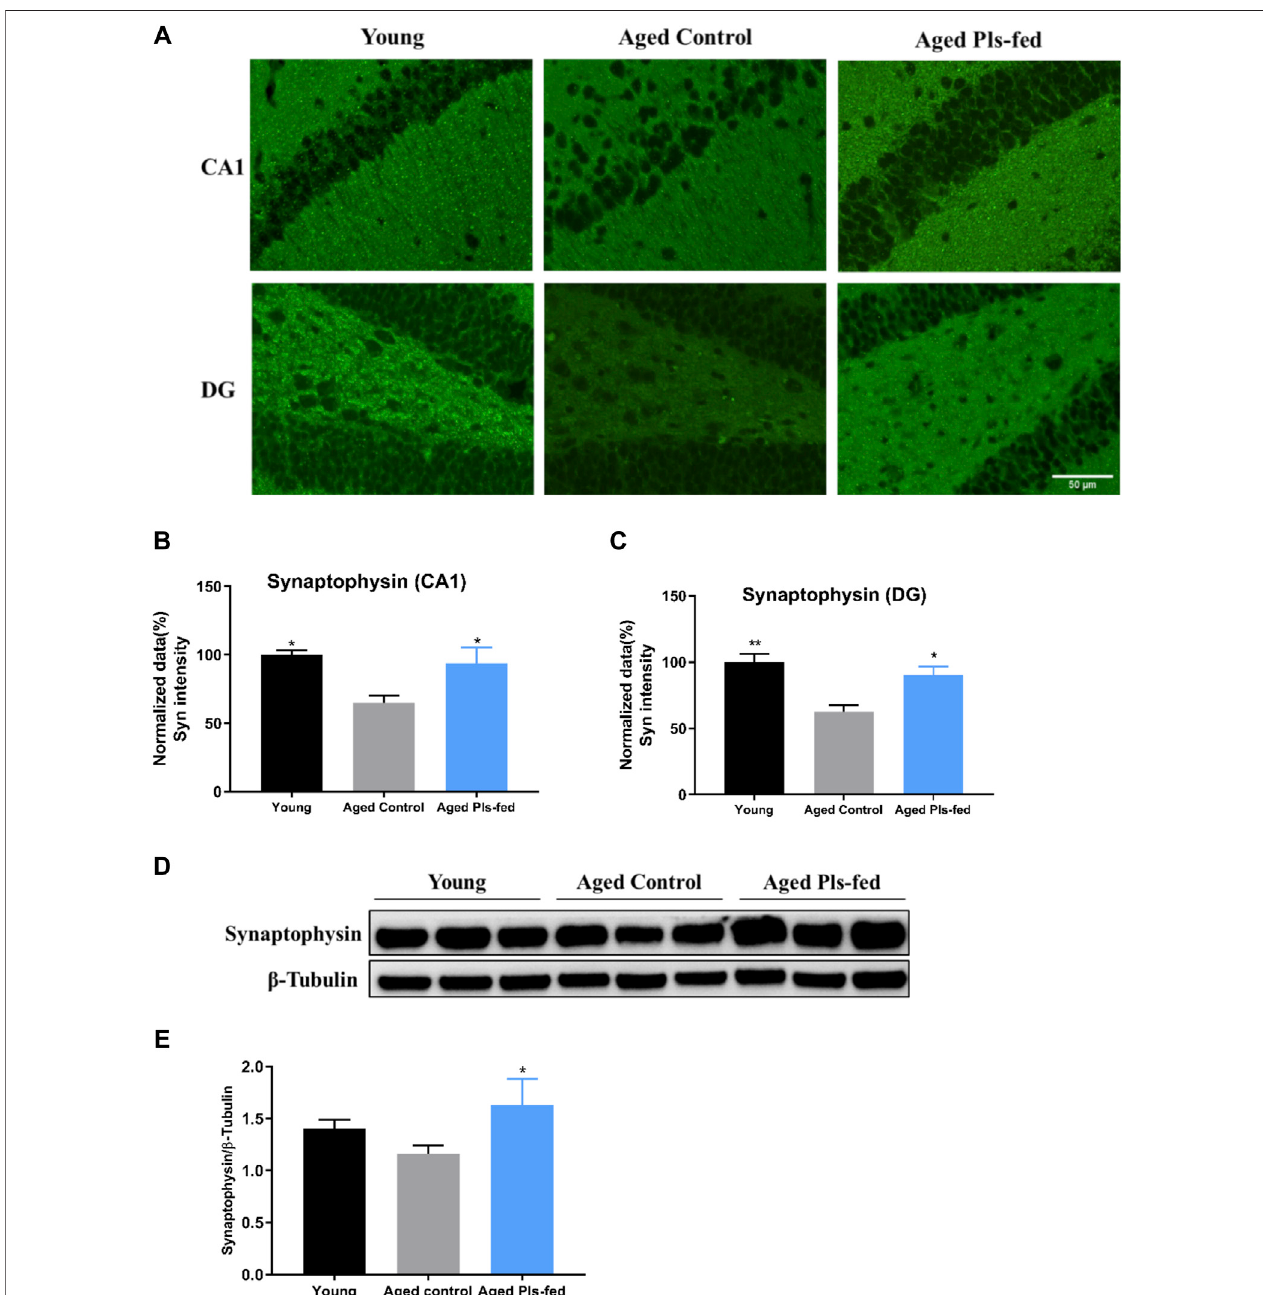
FIGURE 5 | Plasmalogens enhance synaptic plasticity in the hippocampus of aged mice. (A) Representative images showing the expression of synaptophysin (green)intheCA1andDGregionofmicehippocampus. (B – C) Graphshowingquanti fi cationoftheimmunostainingofsynaptophysinintheCA1andDGregionofmurine hippocampus( n =4miceforeachgroup), andvaluesarepresented asmean±SEM. (D) Representativeimmunoblottingofsynaptophysinlevels and (E) graphshowing quanti fi cationofsynaptophysinlevels.Thequanti fi cationisaratioofsynaptophysin/ β -tubulinlevels( n =3micepergroup),andvaluesarepresentedasmean±SD. Asterisks indicate statistical signi fi cances compared to Aged control by one-way ANOVA; signi fi cance (* p < 0.05; ** p < 0.01), scale bars, 50 μ